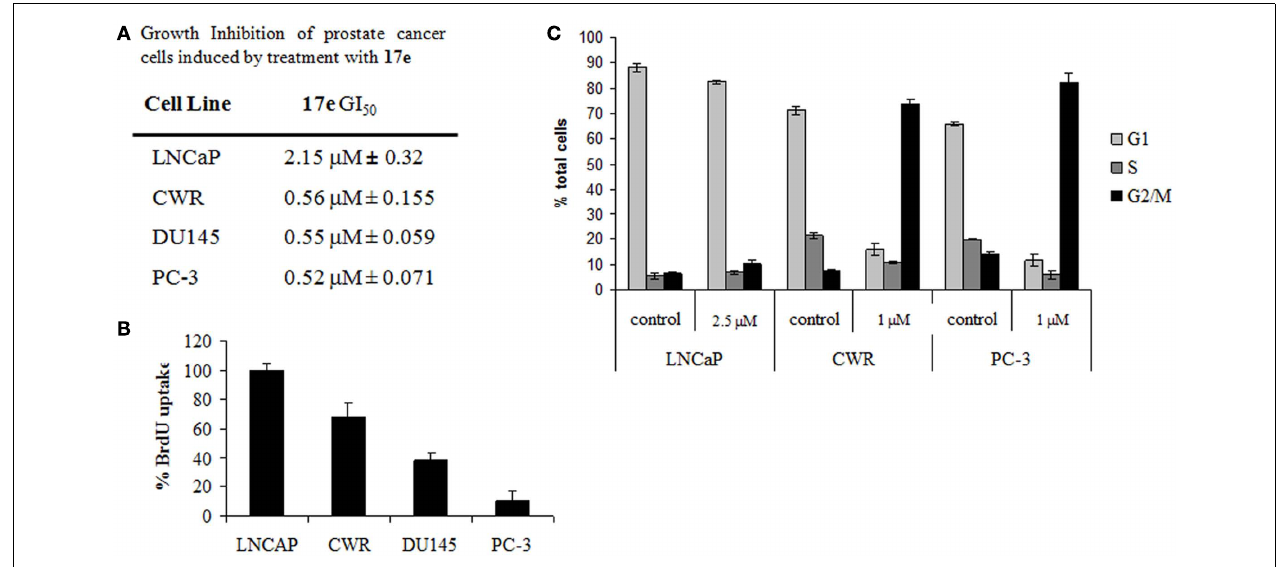
analysis of prostate cancer cells treated with 17e . CWR22RV1 and PC-3 cells demonstrate G2/M arrest after 24h of 17e treatment while LNCaP cells show little change from control. Error is represented as SEM, n =